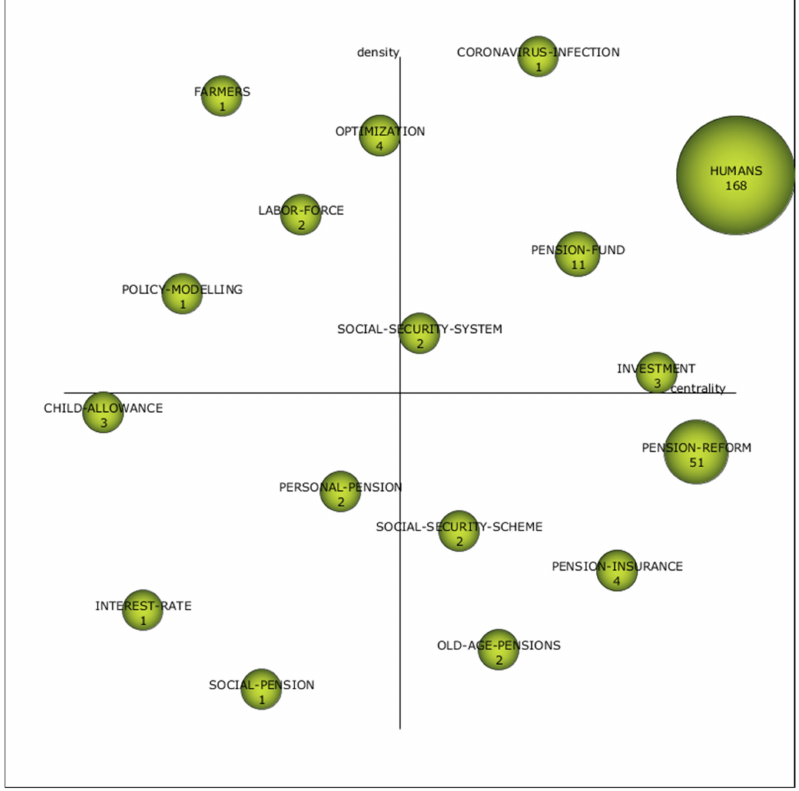
Figure 8. Strategic diagram of keywords on pension research from